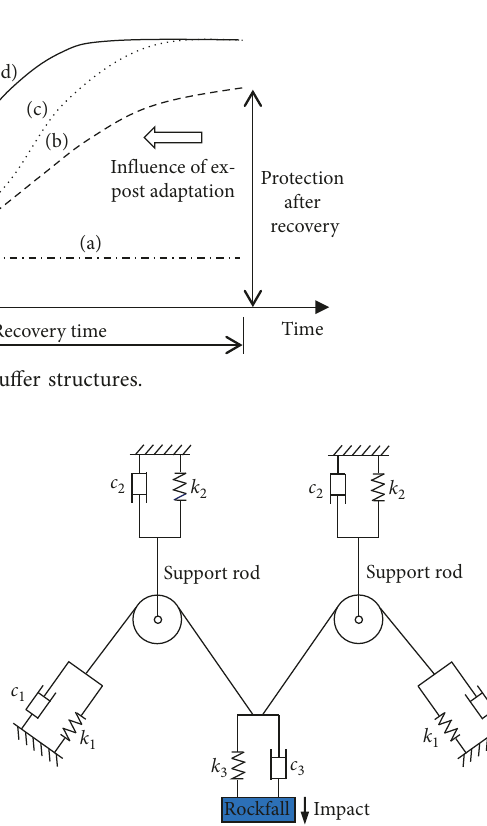
Figure 5: Conceptual model of an impact-resilient buffer structure.